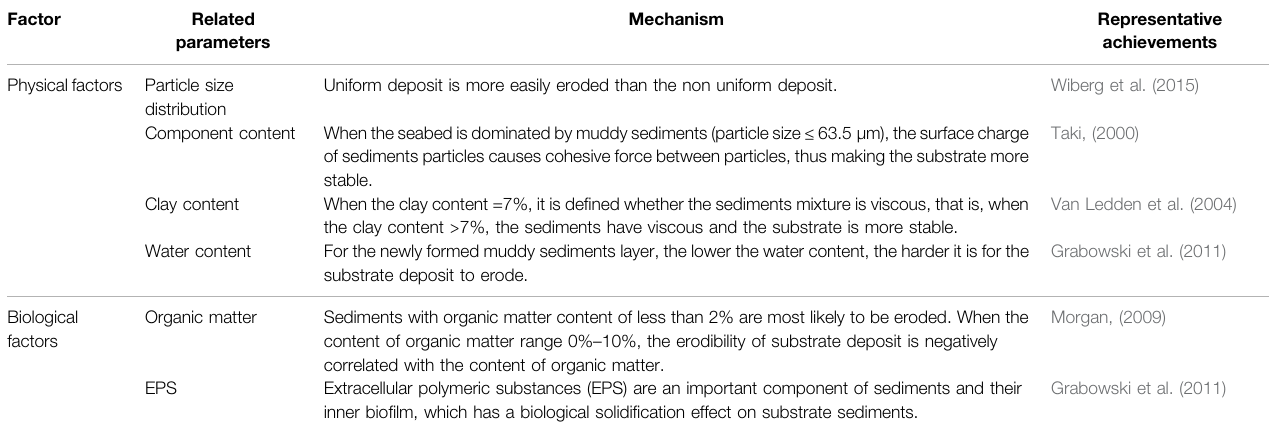
TABLE 1 | Relevant research on factors affecting sediment erosion